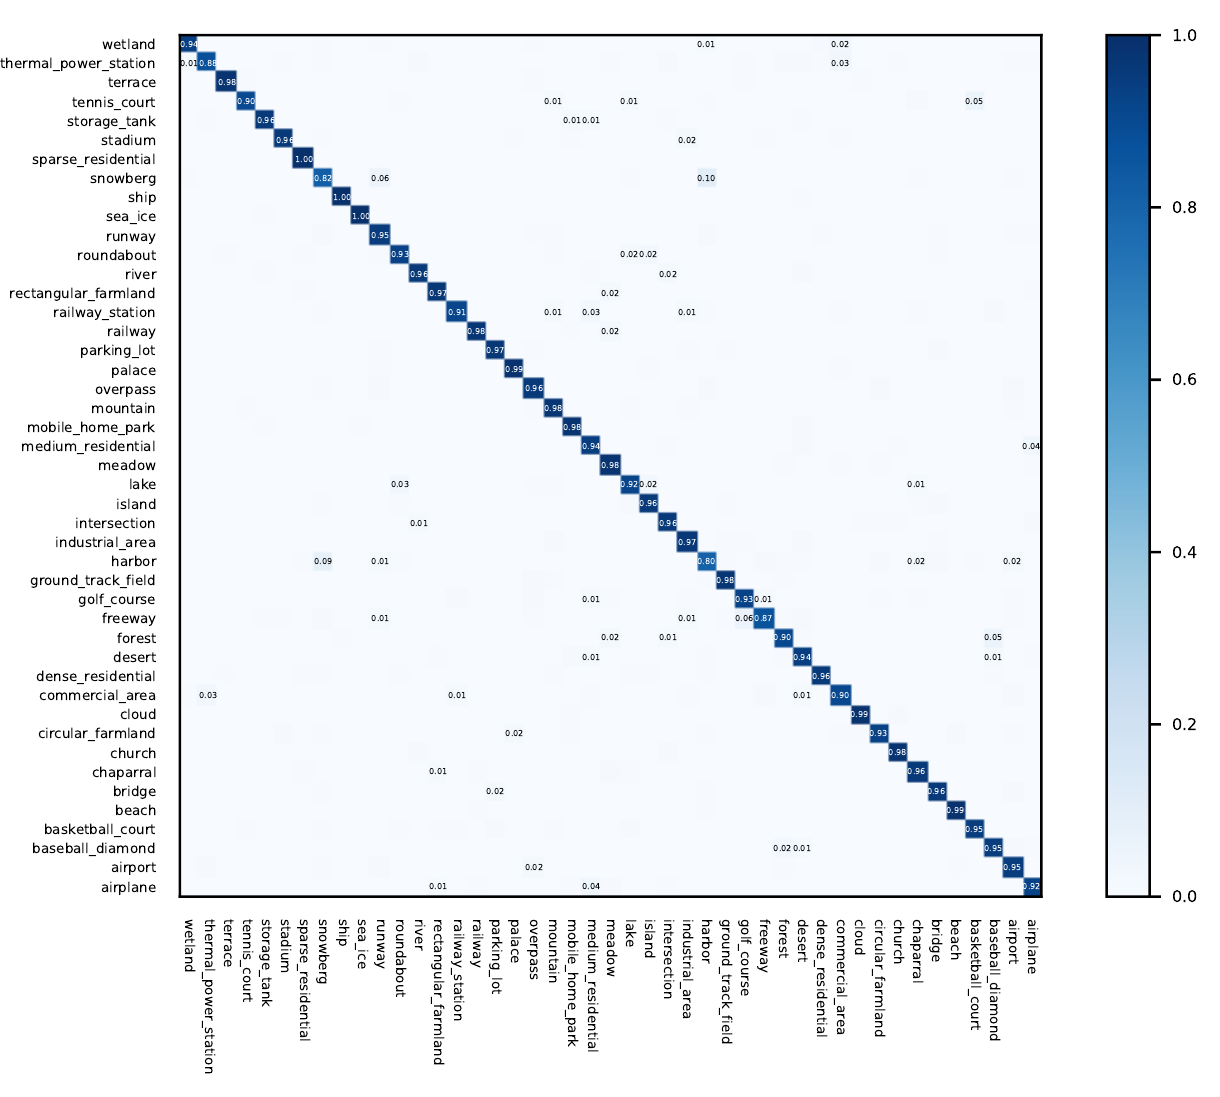
Figure 5. Confusion matrices produced by the proposed approach. We set the training ratio as 80% on the NWPU-RESISC45